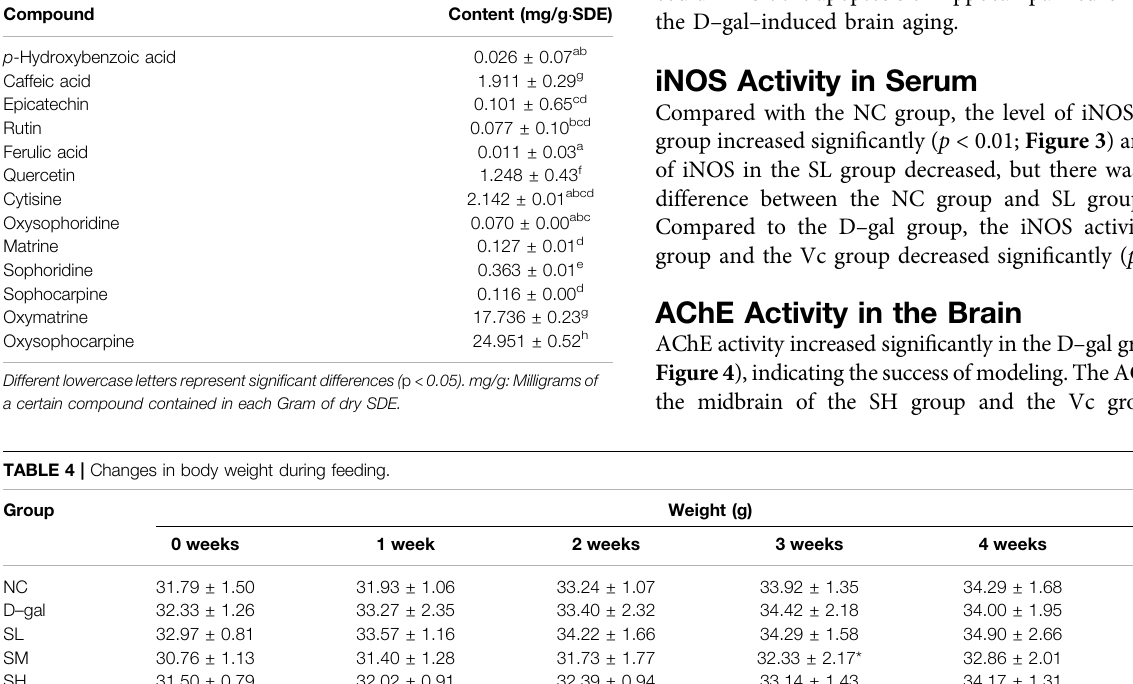
TABLE 3 | Quanti fi cation of major polyphenols and alkaloids in SDE. Compound p -Hydroxybenzoic acid